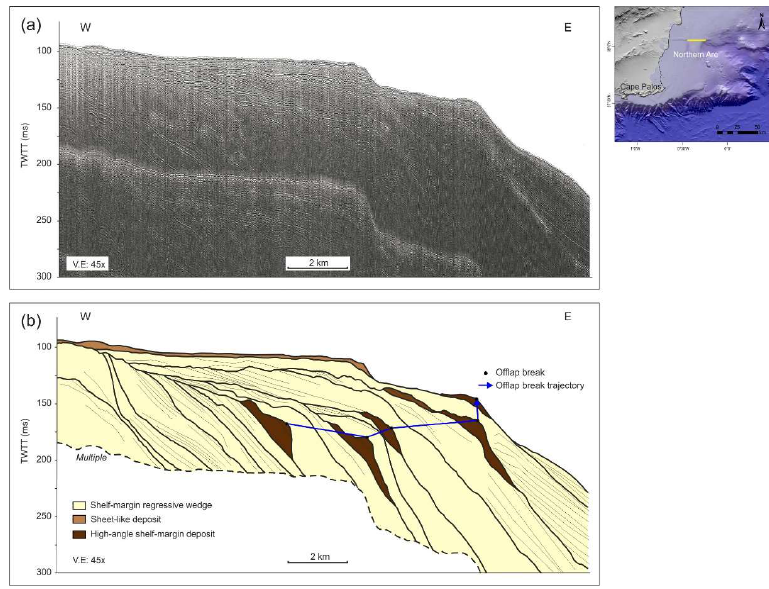
Figure 9. ( a ) Uninterpreted and ( b ) interpreted high-resolution Sparker seismic reflection profile of the shelf of the Northern Arc. The Quaternary record shows a strong development of shelf-margin regressive wedges with intercalated high-angle shelf-margin wedges, which constitutes a peculiarity along the Iberian Mediterranean margin. The shelf-edge trajectory displays a dominant flat trend. Modified from [11].